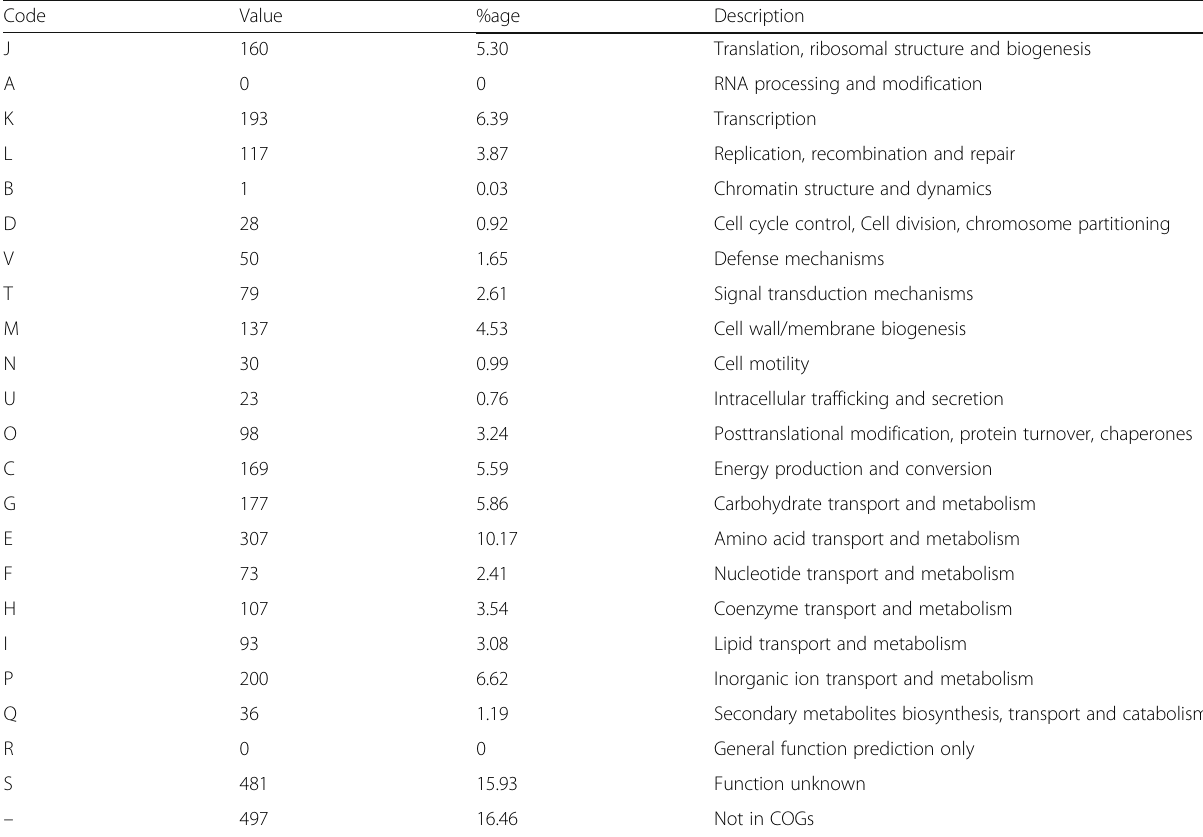
Table 4 Number of genes associated with general COG functional categories